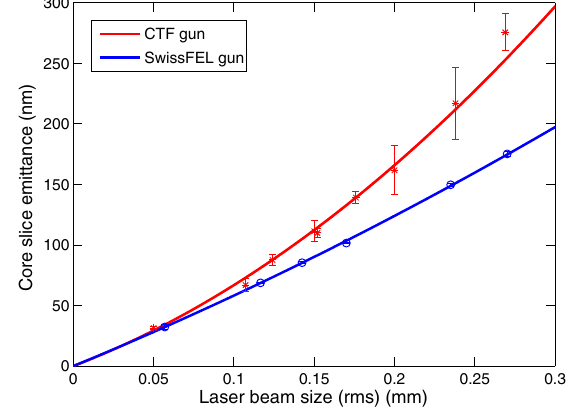
FIG. 59. Two examples of aperture scans showing core slice emittance measured for various laser spot sizes with the CTF gun (red asterisks) and the SwissFEL gun (blue circles). The dependence observed for the CTF gun features a distinct quadratic component (see text for details). In both cases the electrons were extracted from a copper